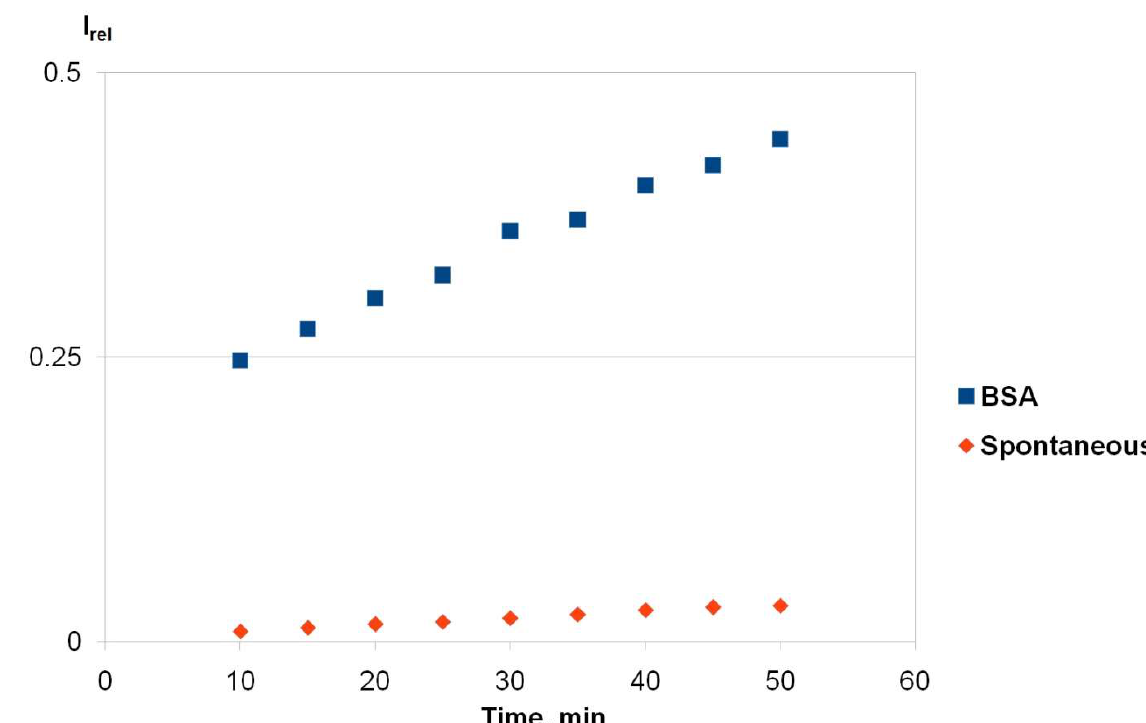
Figure 3. Dependence of the relative integral intensity I rel of the acetate signal in the reaction mixture in the presence and in the absence of BSA. I rel was calculated as the ratio of the integral signal intensity of acetate (I acetate ) to the integral signal intensity of the internal standard sodium trimethylsilylpropanesulfonate (I DSS ): I rel = I acetate /I DSS .